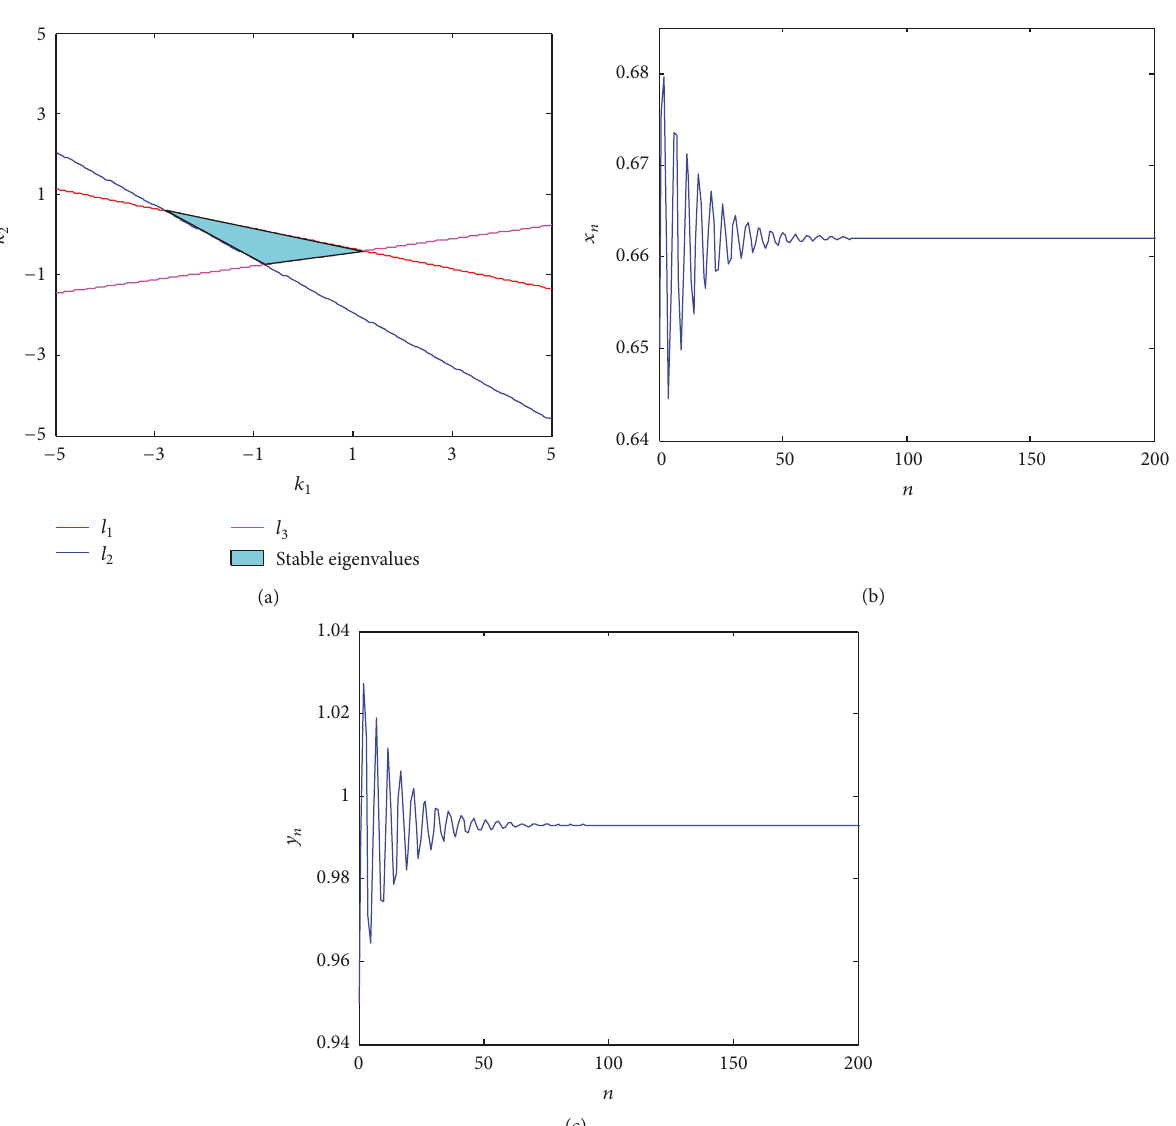
Figure 5: Control of chaotic trajectories of system (43) . (a) Stability region in (𝑘 1 , 𝑘 2 ) plane. (b-c) Time series for states 𝑥 and 𝑦 , respectively.